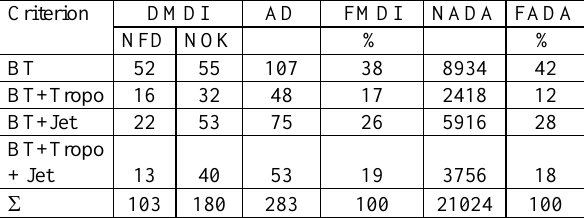
Table 1. Summary of successful detection of dry intrusions based on selected criteria. BT - Criterion of local maxima in the